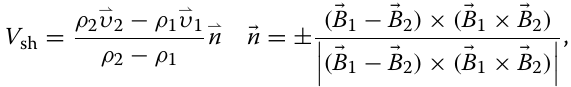
Detailed comparison of the compressional front ~280 km/s. The estimated com- the sound velocity is V s = recorded by the THEMIS probes reveals a clear propa- pression front propagation velocity, neglecting the wave front orientation, is much less than the local Alfven velocity, gation effect, indicating the time delay between the so the Alfven Mach number is estimated to be M A compression fronts in component B t at probes E and ~0.2. = D of Δ t 15 s and between probes D and A of Δ t 10 s There is the possibility of estimating the shock veloc- = = (Fig. 6, top panel). These delays correspond to the appar- ity V sh and shock normal to the front n from single point measurements using the coplanarity theorem (i.e., the ent velocity of the magnetic compression propagation absence of E parallel to n ) from the relationships (Oliveira V ED ~300 km/s and V DA ~240 km/s. For the simulta- = = neously recorded local plasma and magnetic field param- eters ( N p 0.8 cm − 3 , background electron temperature = T e 800 eV, and B 75 nT), the local Alfven velocity is = = = 22 B ( nT)/ (cid:31) N ( cm − 3 ) V ~1800 km/s, and A ( km/s) =